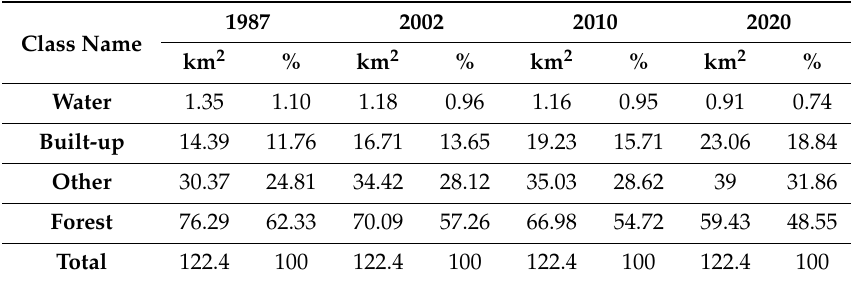
Table 3. Results of land-use / land cover classification